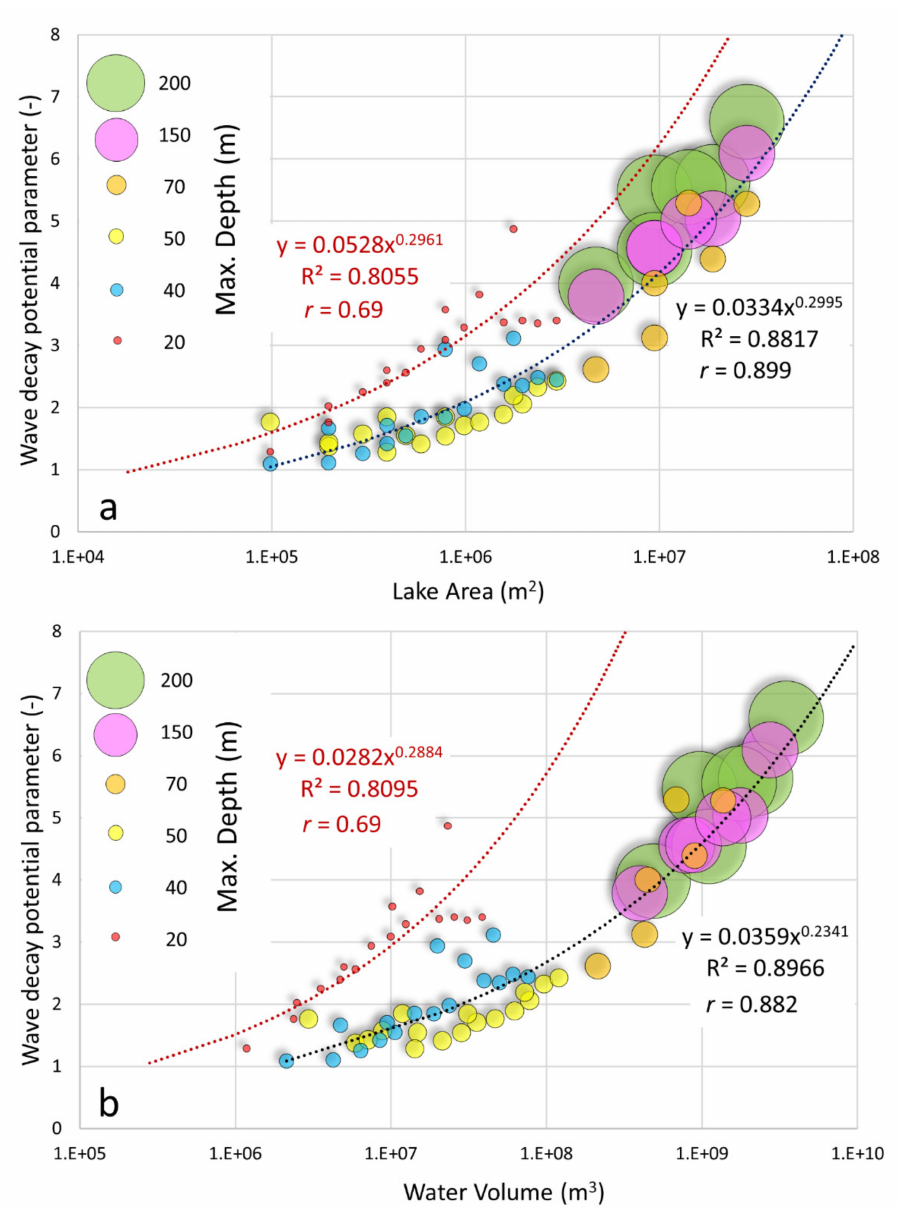
Figure 7. Hyperbolic relations between WDPP and ( a ) lake area and ( b ) water volume (X-axis in logarithmic scale, base 10). Circle size and color relate to lake depth. Related equations, coefficient of determination ( R 2 ), and correlation coefficient ( r ) are also shown. The r -values labeled in red, which are not shown in Figure 6, are correlation coefficients specifically for medium-size lakes with a maximum depth of 20 m. The r -values labeled in black, shown in Figure 6b, are correlation coefficients for theoretical lakes with a maximum depth greater than 20 m. Table 2. Correlation coefficients ( r ) between WDPP and A , V w , and ShpP ; equations; and